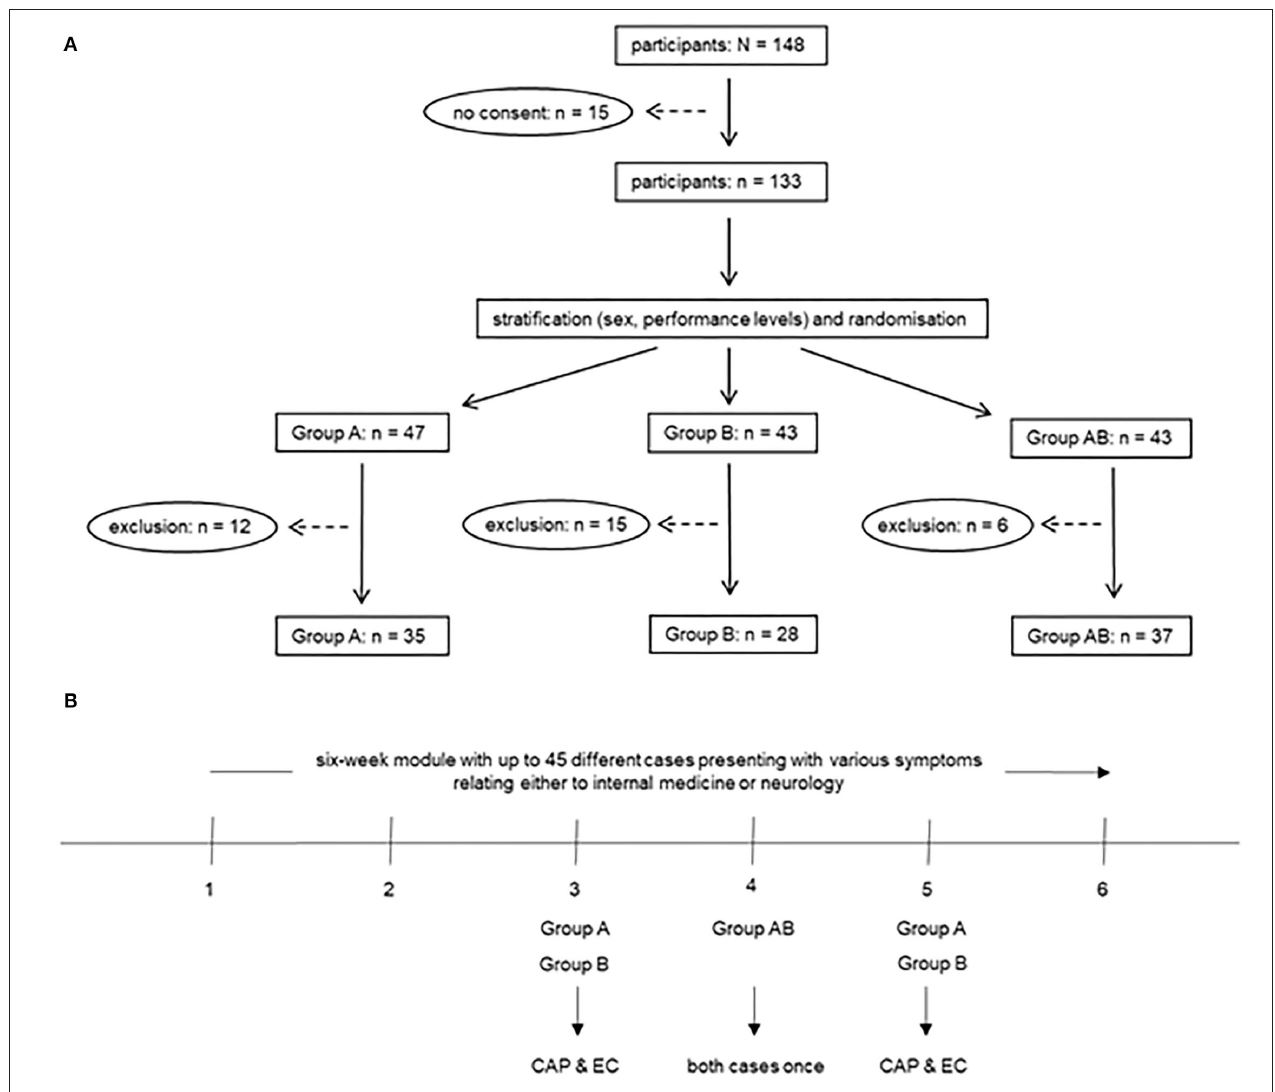
FIGURE 1 | (A) Flow of participants through the study. Exclusion was due to non-compliance with the study protocol (e.g., when students were erroneously exposed to the wrong cases at least once because they did not attend the session they had been assigned to but participated in a different session). (B) Time course of the